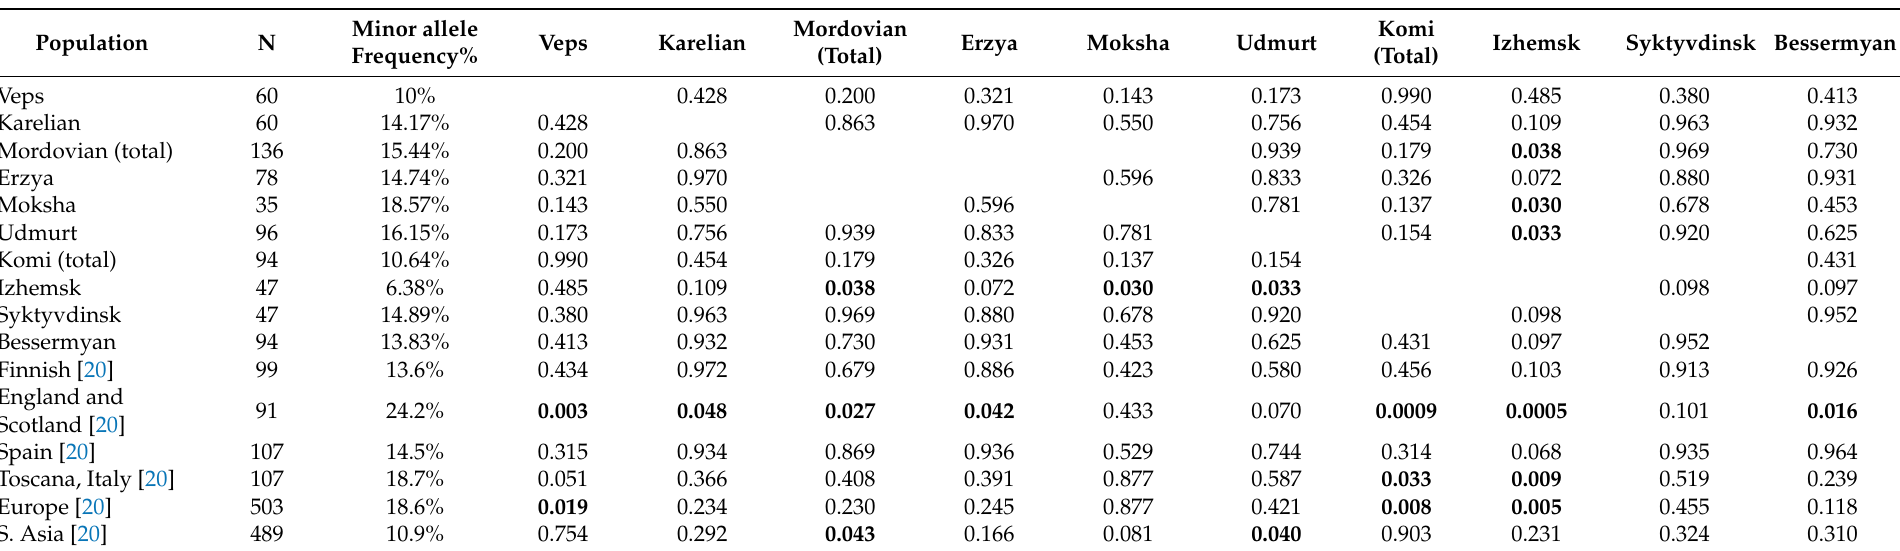
Table 7. Frequencies of the minor allele rs3892097 of the CYP2D6 gene in the studied samples of Finno-Permic peoples, as well as in some populations of the